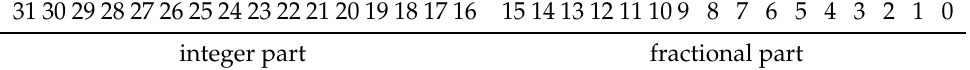
Table 2. Fixed-point Q16.16 on 32-bit